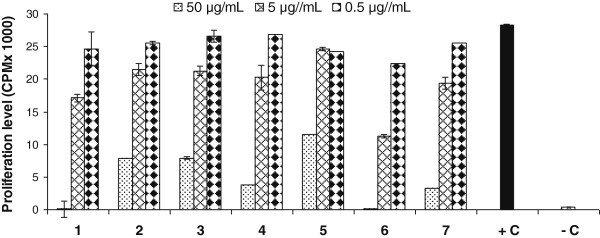
Effect of compounds 1–7 on phytohemagglutinin (PHA) activated T-cell proliferation. The effect of compounds on the T-cell proliferation is compared with control. Each bar represents the mean value of triplicate reading ± SD.